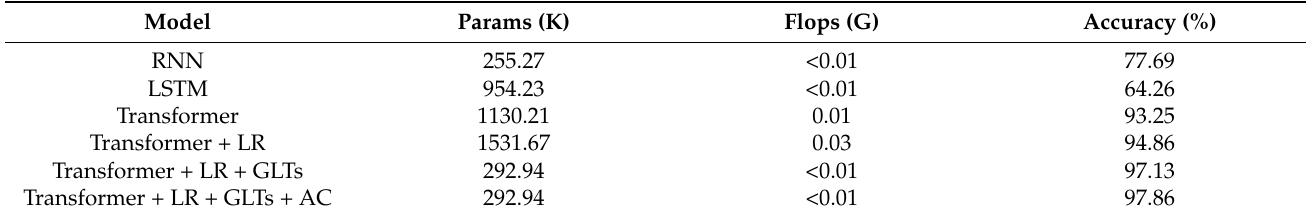
Table 4. Model parameters and